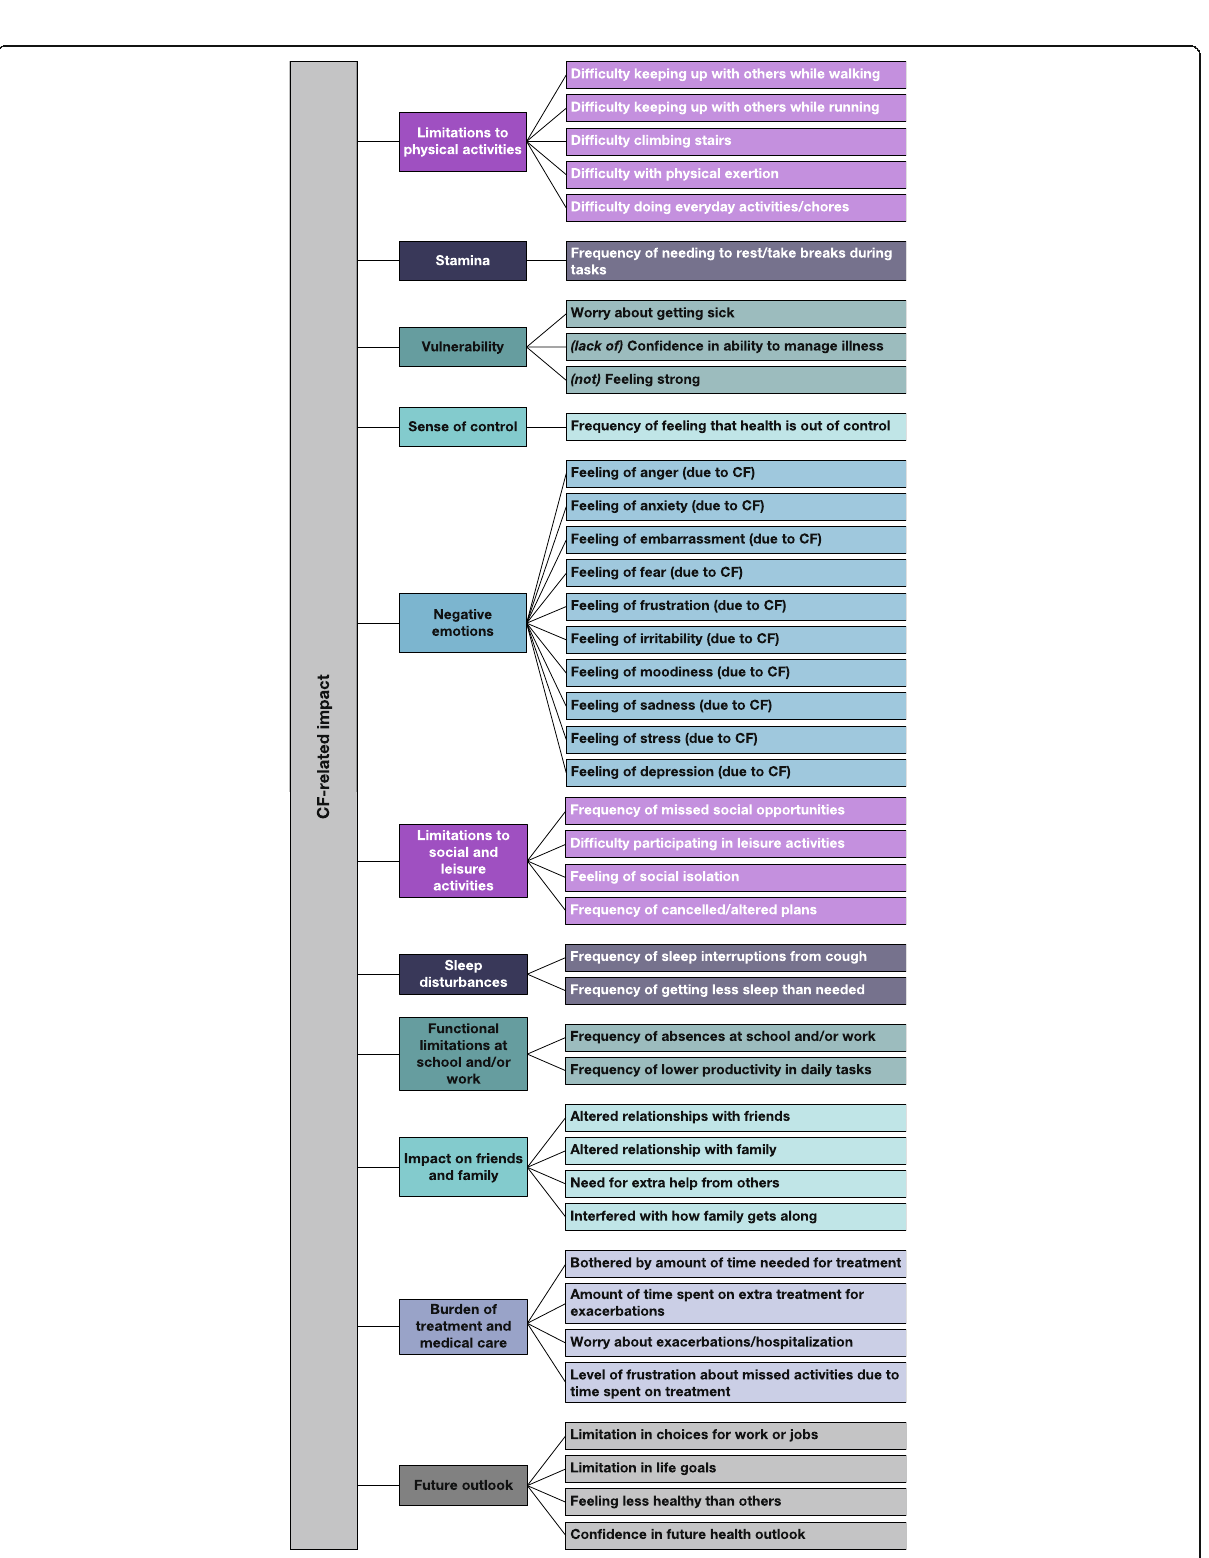
Fig. 2 Conceptual framework for the Cystic Fibrosis Impact Questionnaire. CF cystic